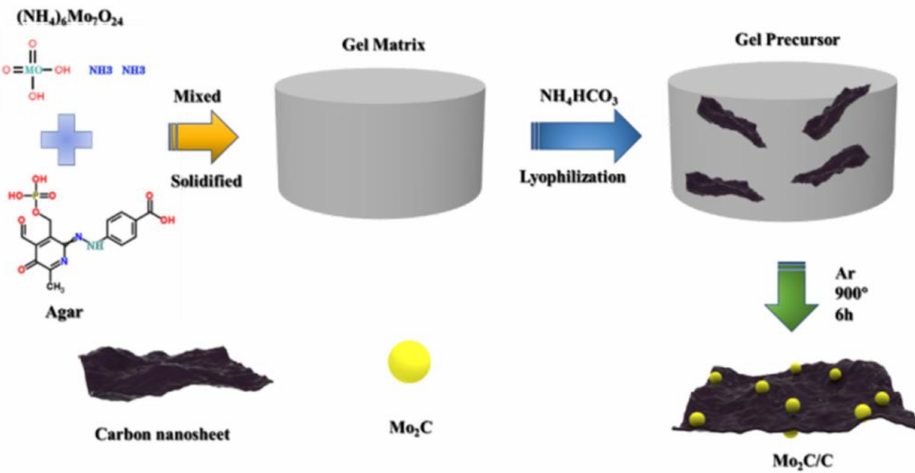
Figure 1. Schematic diagram of the preparation process of Mo 2